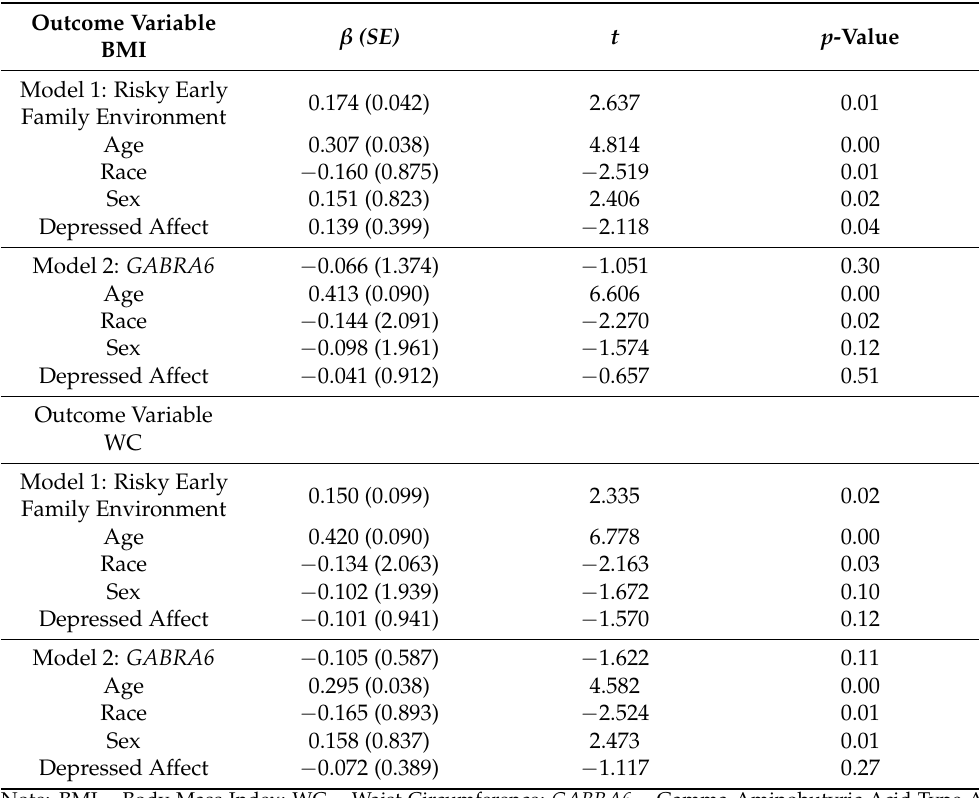
Table 2. Summary of multiple regression